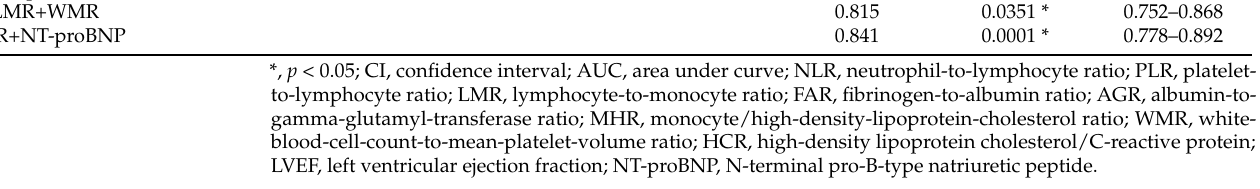
8 of 14 Table 6. Pearson correlation analysis of SII and echocardiography indexes. Index